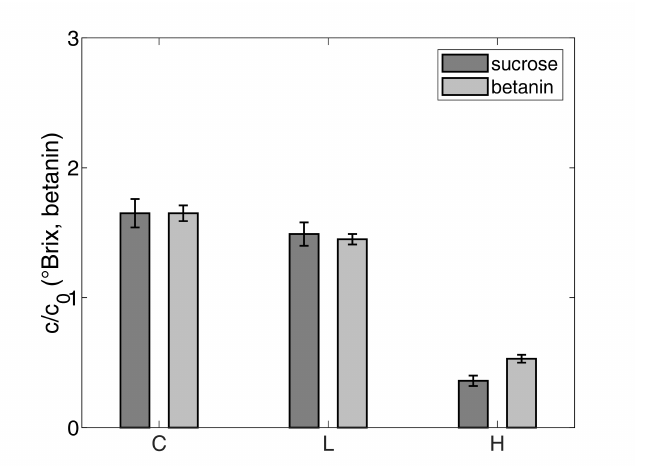
Figure 6. Quotients of the reached concentrations c after hydrate formation in the water-sucrose- betanin model solution and the initial concentrations c 0 , respectively, for sucrose and betanin; C: concentrate, L: drained liquid from the hydrate, H: hydrate (error bars: standard error of the mean according to Section 2.9, the standard errors of the mean are given in Table